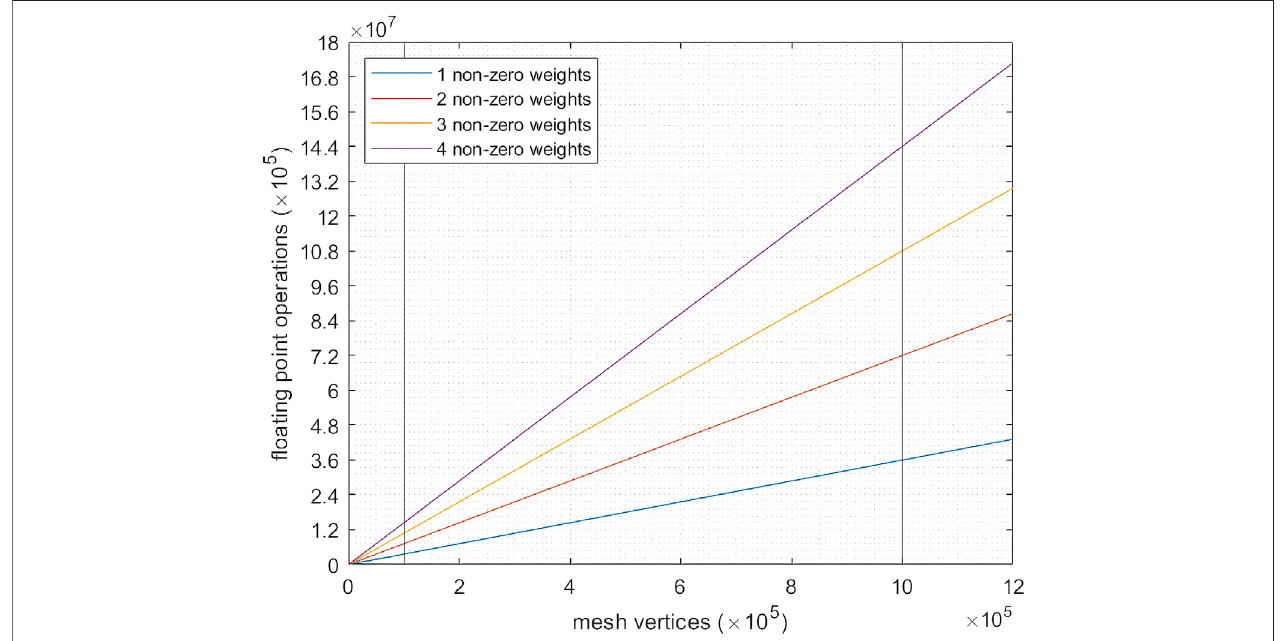
FIGURE 6 | Floating point operations per pose needed for a skinned mesh using the default blender animation pipeline, in relation to armature complexity (number of related bone-pairs to a single vertex), with highlighted comparisons between a mesh requiring 100 k vertices vs. one with 1 M vertices, with the assumed industry standard of a maximum of four associated bone-pairs per